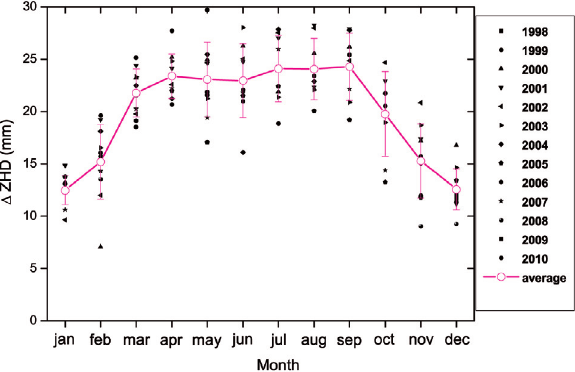
Figure 5. Monthly means of the differences, D ZHD , between the ZHD time series shown in Figure 4 (top). In particular, D ZHD = ZHD − ZHD . The averages of the monthly means are shown p − surf grid with pink circles.